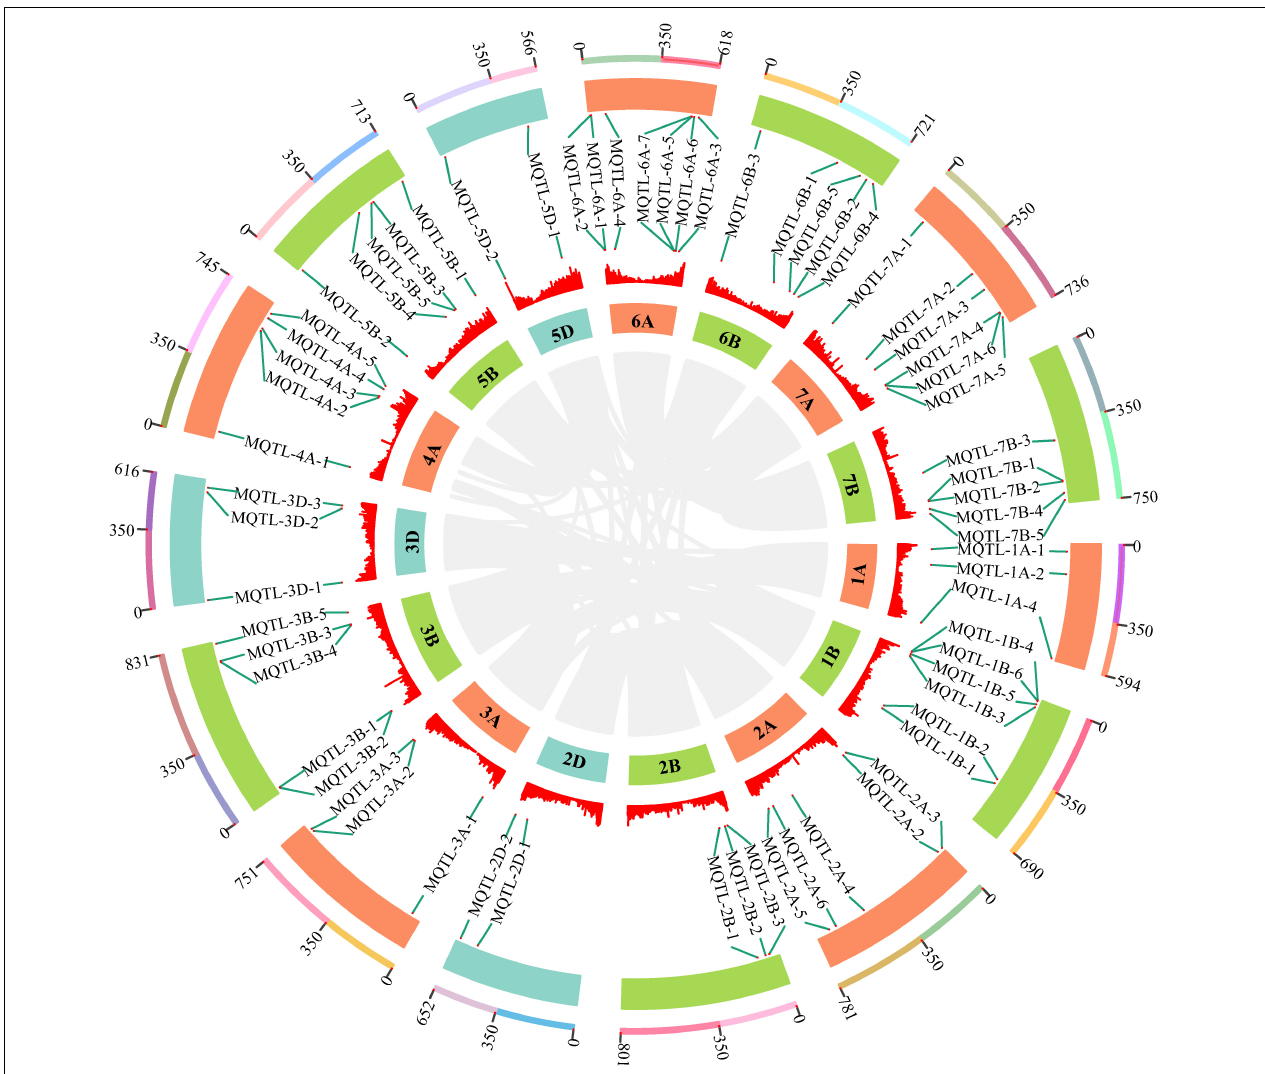
FIGURE 4 | The chromosome distribution of 65 MQTLs for TGW by MQTL analysis. The circles from outside to inside represent the chromosome physical distance (Mb), 65 MQTLs position, density of high confidence genes and wheat chromosome, respectively. The connecting lines in the center of the circular diagram represents wheat genomic collinearity